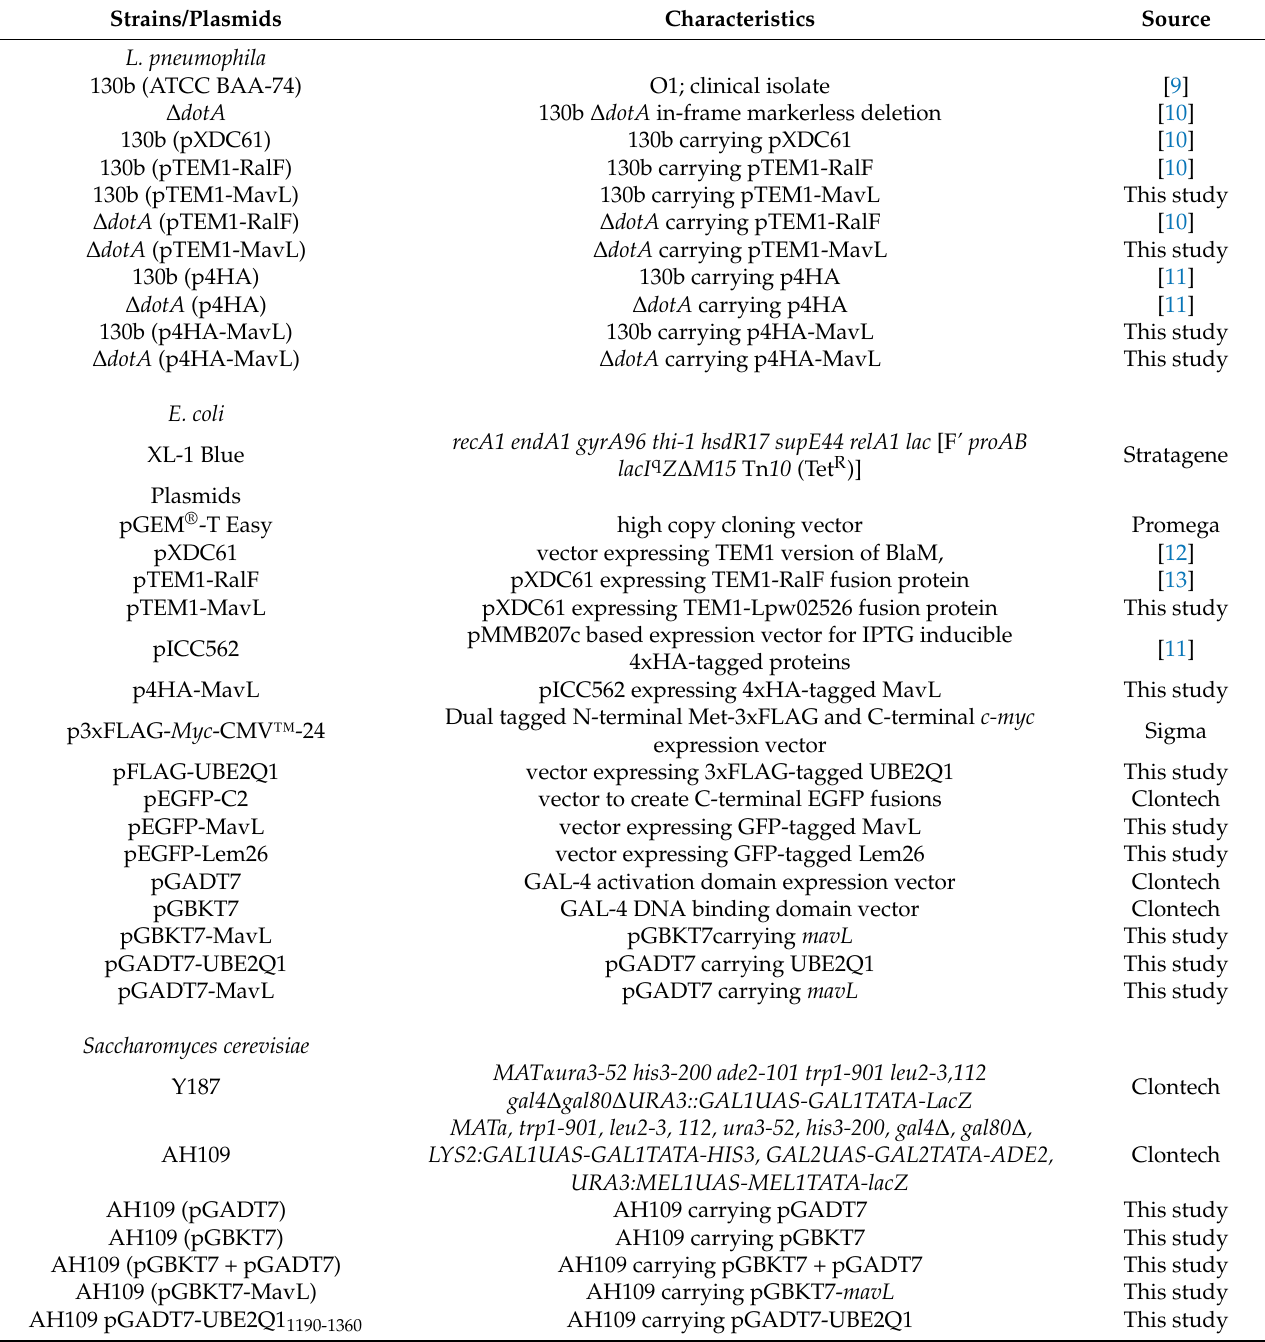
Table 1. Strains and plasmids used in this